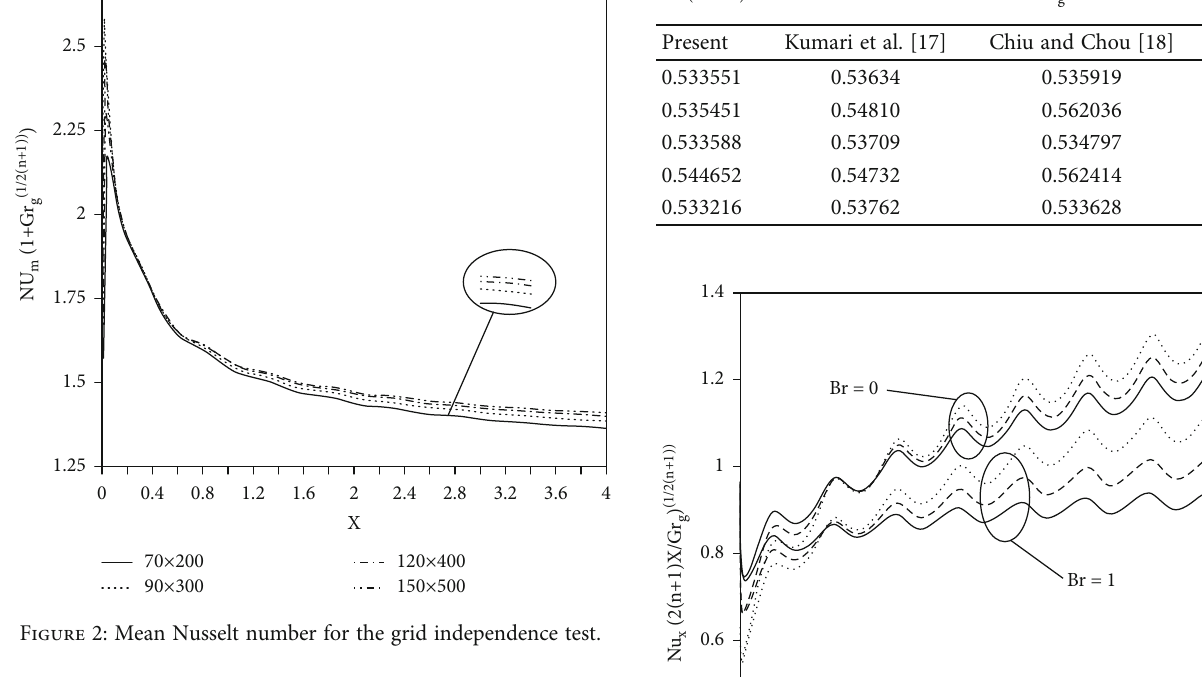
½ 2 n + 1 X Gr (cid:2) g x